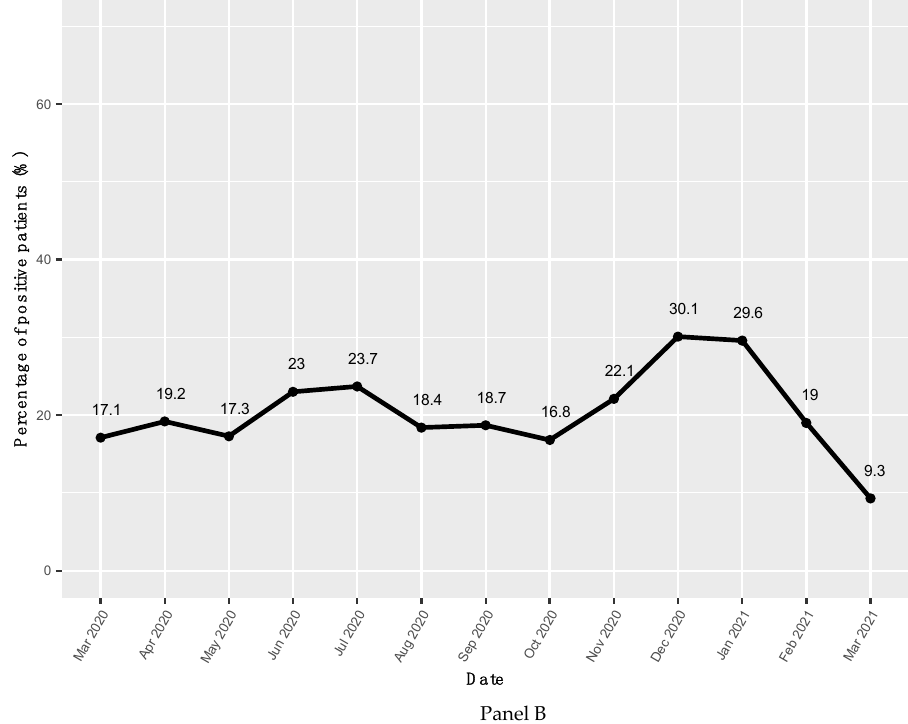
Figure 1. Panel A . The absolute number of COVID-19 tests results, March 2020–March 2021. p -trend for total tests = 0.042; p -trend for positive tests = 0.092. Panel B . Percentage of patients tested positive for COVID-19, March 2020–March 2021. p -trend = 0.834.